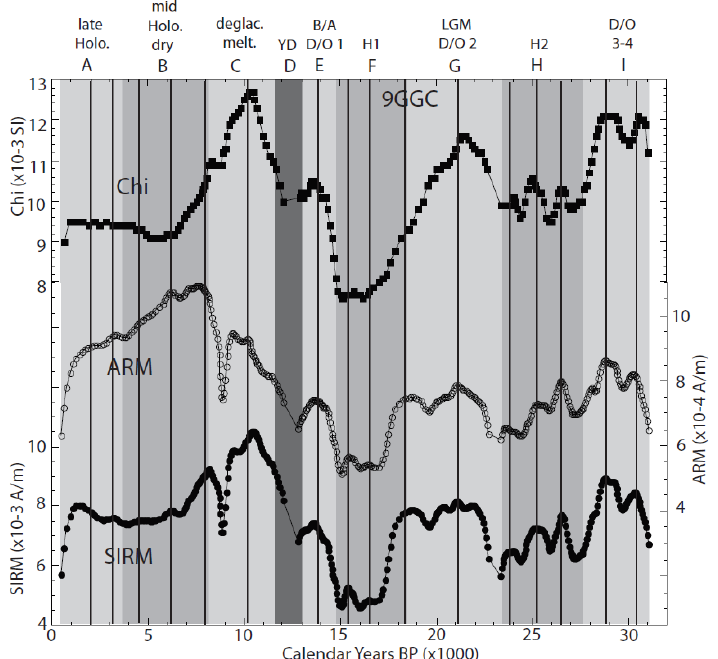
Figure 6. Rock magnetic intensity variability for core 9GGC versus time. Alternating light and dark grey zones are multi-millennial-scale oscillations in magnetic intensity (light = higher intensity, dark = lower intensity) labeled A-I. Vertical lines estimate finer-scale millennial intensity peaks that are superposed on the longer-term variability.